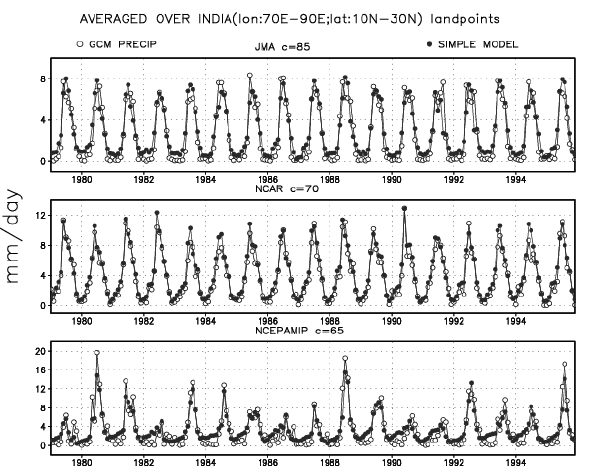
Fig. 4. Seasonal variation of precipitation over India in NCEP, NCAR and JMA GCM and simple model (Eq. 10) during 1979– 1995.